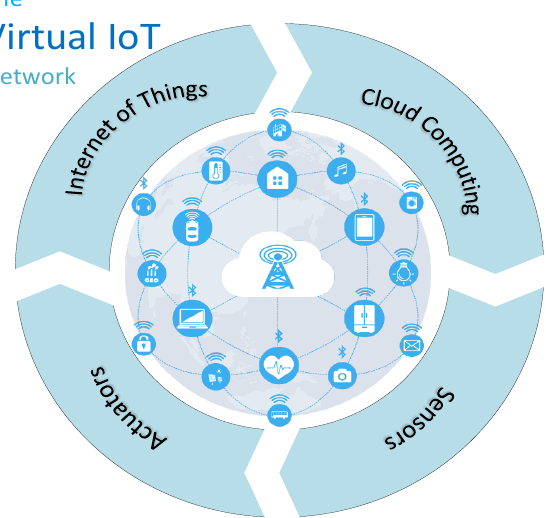
Figure 1. Convergence and evolution of network